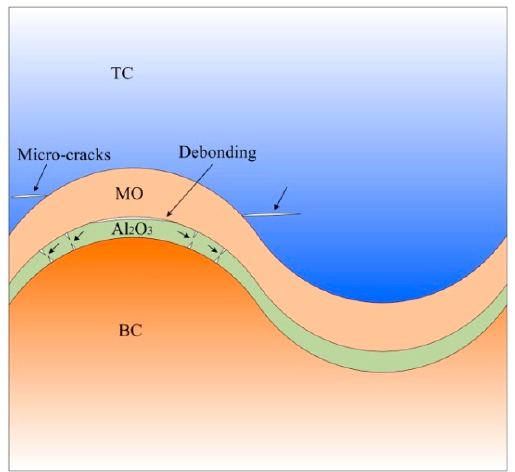
Figure 9. Schematic diagram of the failures induced by the growth of uniform MO in TBCs [11].